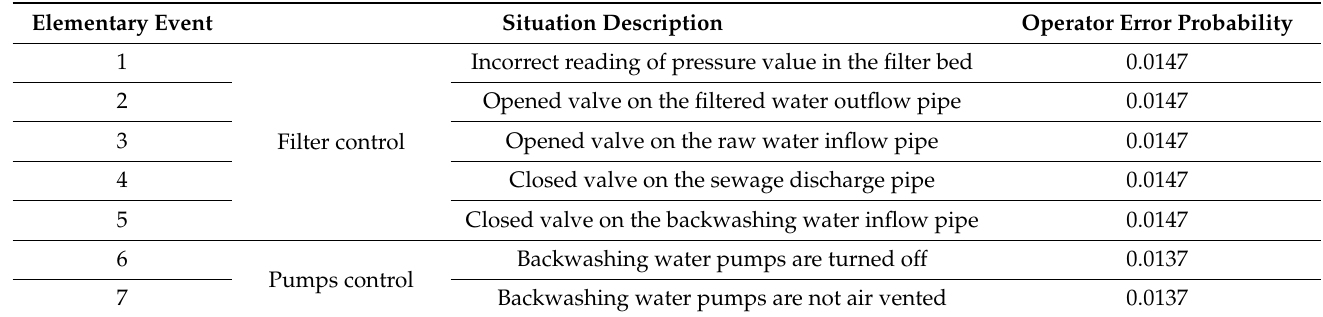
Table 3. The probability of elementary